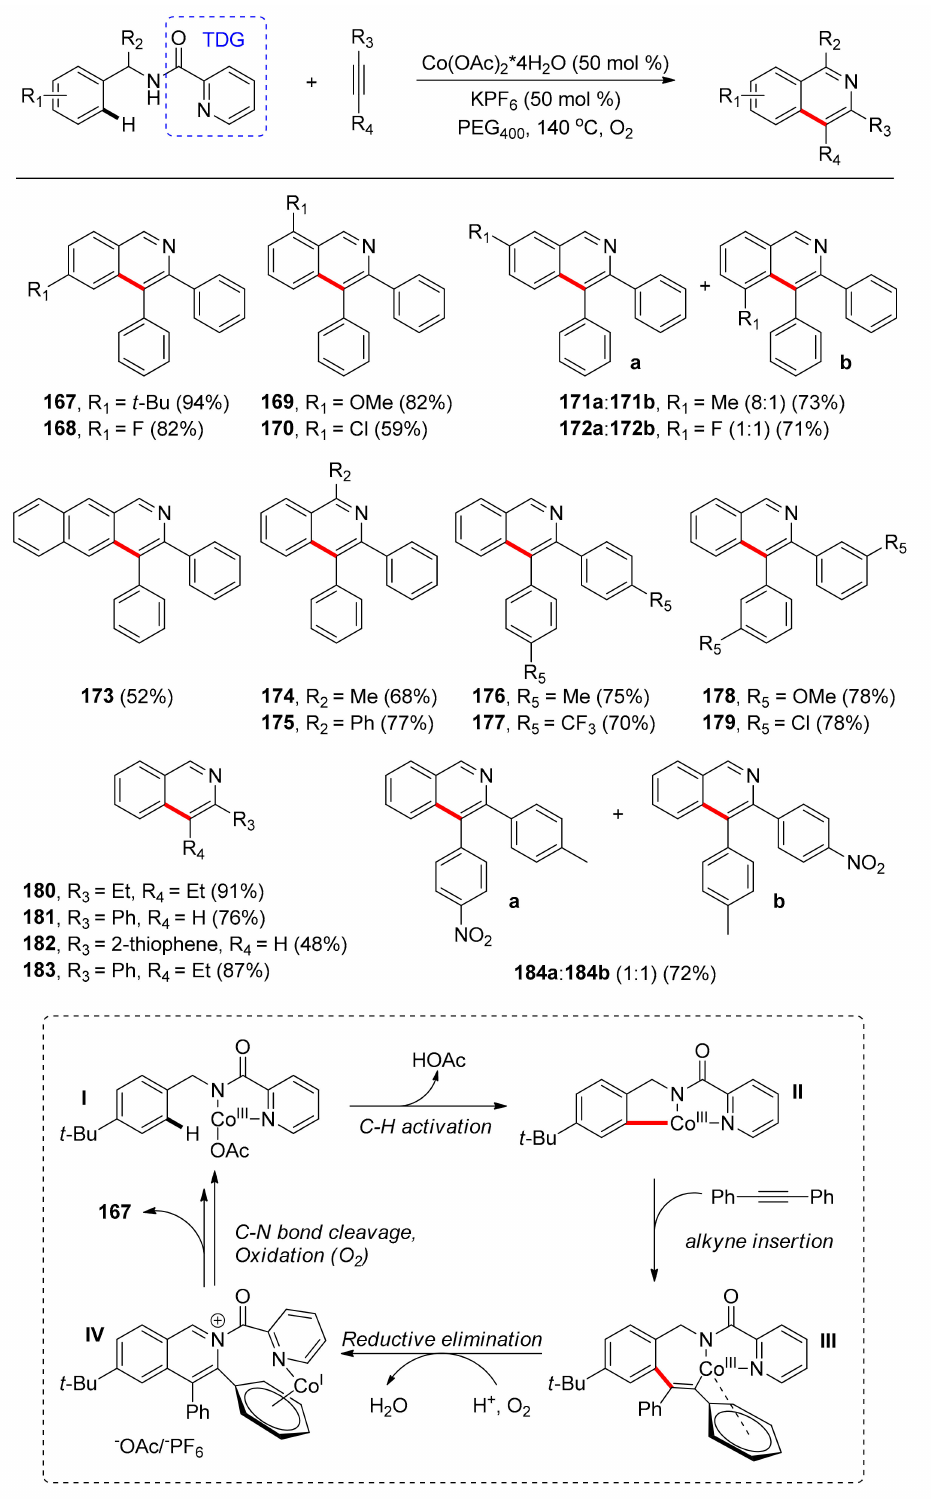
Another protocol towards the Cp*-free, cobalt-catalyzed, TDG-assisted, synthesis of isoquinolines was reported by Song and co-workers in 2019 [108]. Substituted isoquino- lines are important heterocyclic compounds found in chiral ligands and pharmaceuticals, amongst others. For their synthesis, the cheap and readily available Co(acac) 3 salt was used as the catalyst in 20 mol % loading. Alternative cobalt sources including